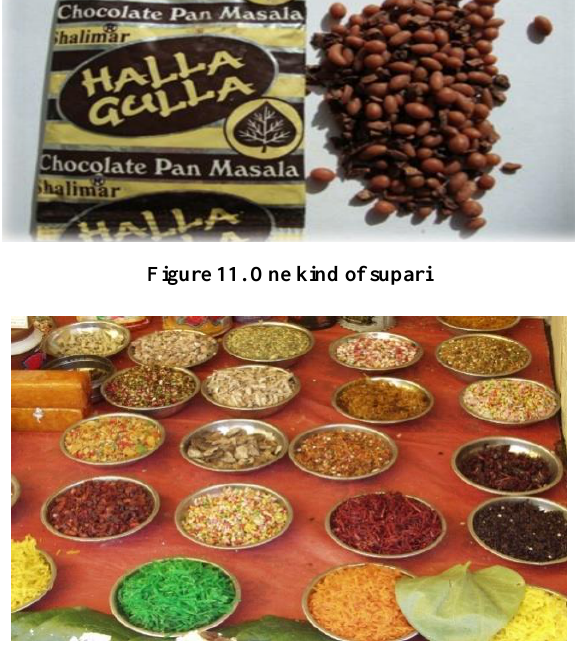
Figure 12. Various materials used in supari